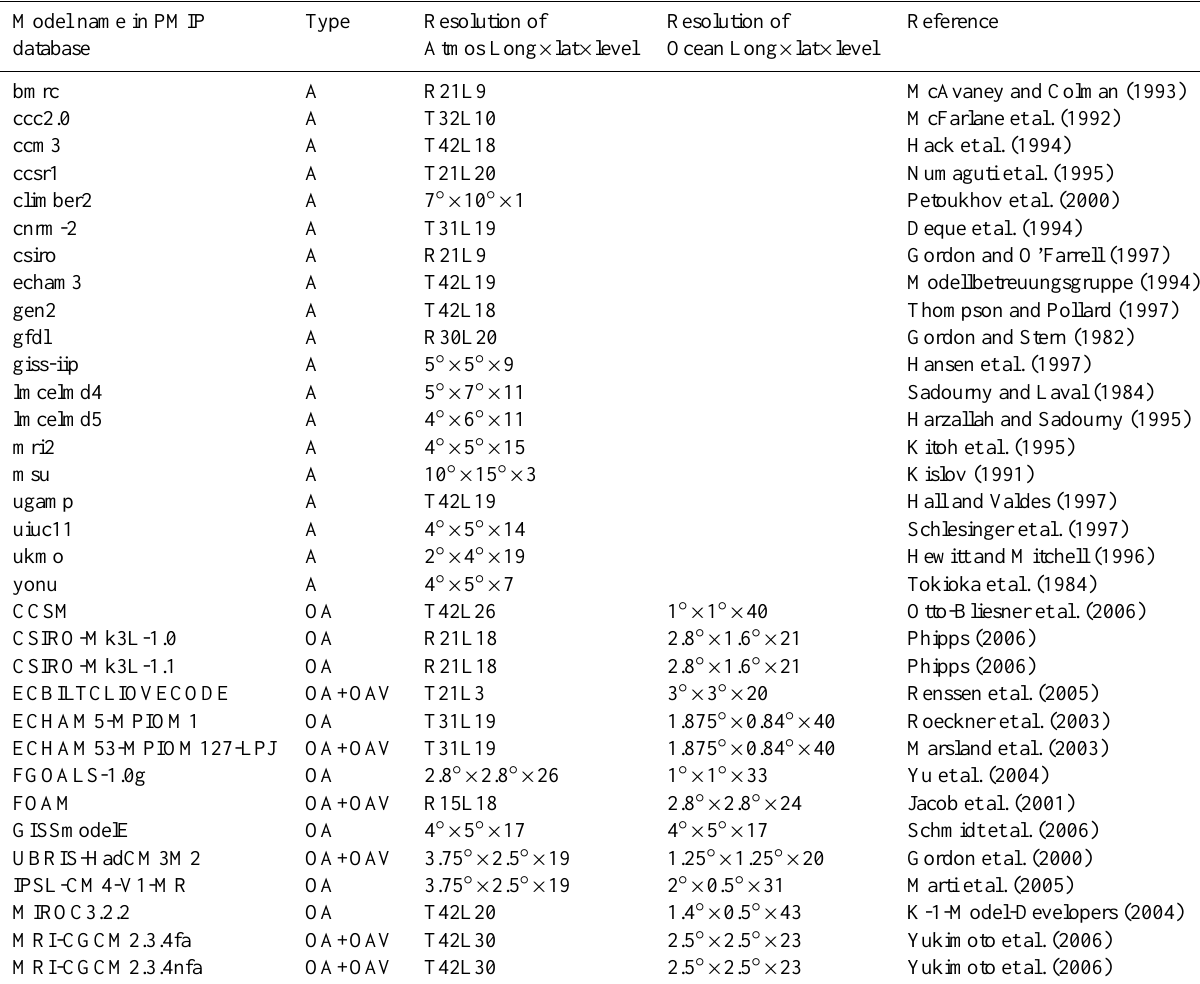
Table 1. PMIP models used in this study. The model name is listed as specified in the PMIP database. Type A refers to an atmosphere- only model with fixed SST, OA refers to a coupled ocean-atmosphere and OAV refers to a coupled ocean-atmosphere-vegetation model. OA+OAV means the model has both simulations. The resolution of the spectral models is given by the type of truncation, the highest total wavenumber, and the number of vertical levels, while for the grid models it is given in longitude(degree) × latitude(degree) × vertical